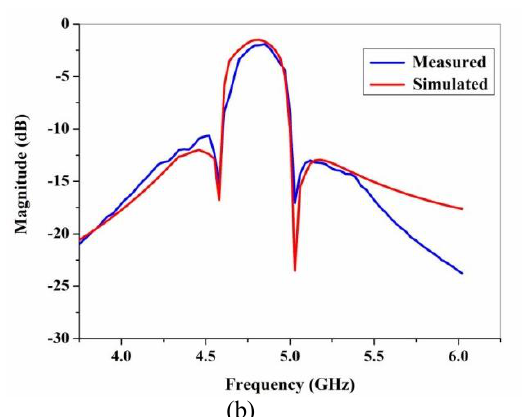
Figure 12: Simulated and measured results of bandpass filter using both horizontal and vertical slots (Filter C) (a) return loss, (b) insertion